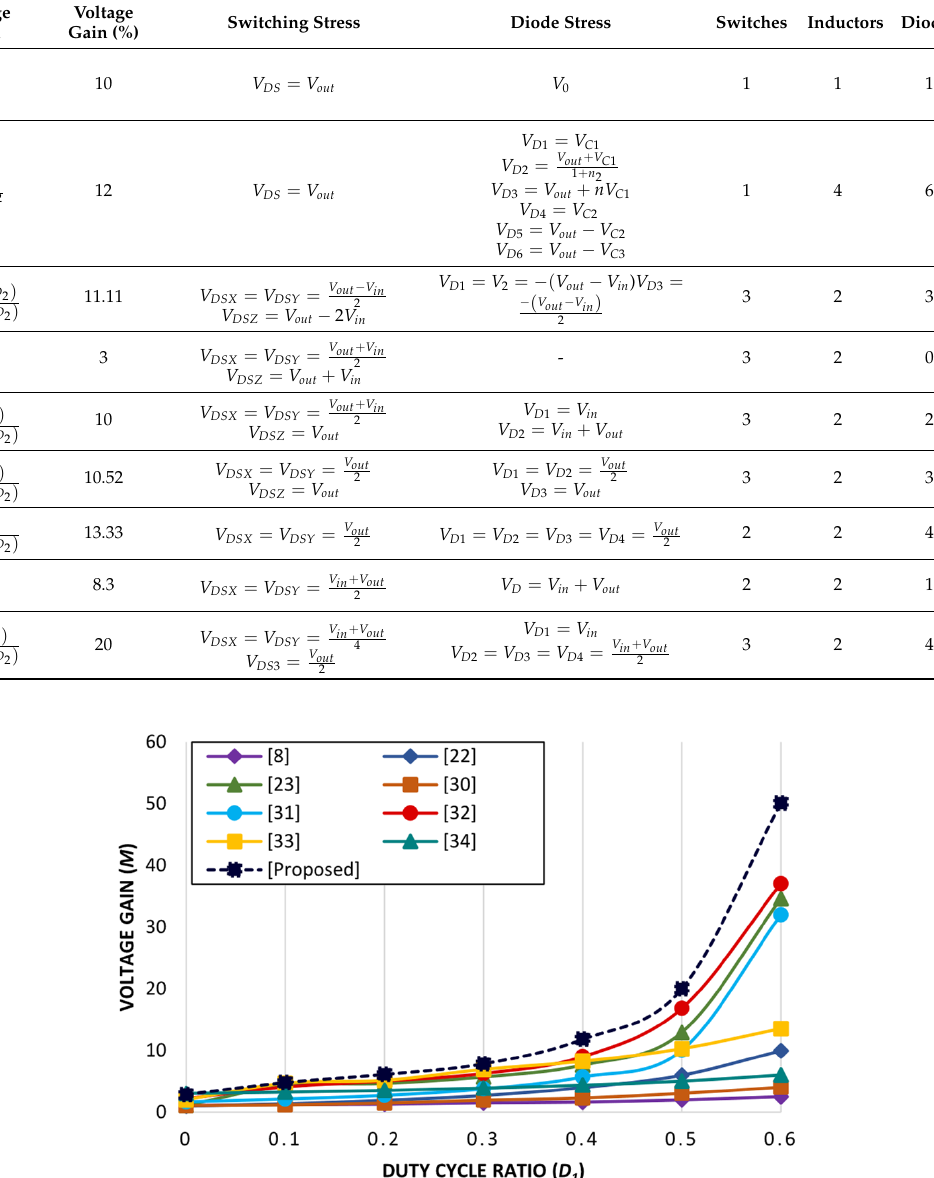
Figure 6. Voltage gain response under varying duty ratios D 1 and D 2 for the proposed converter.